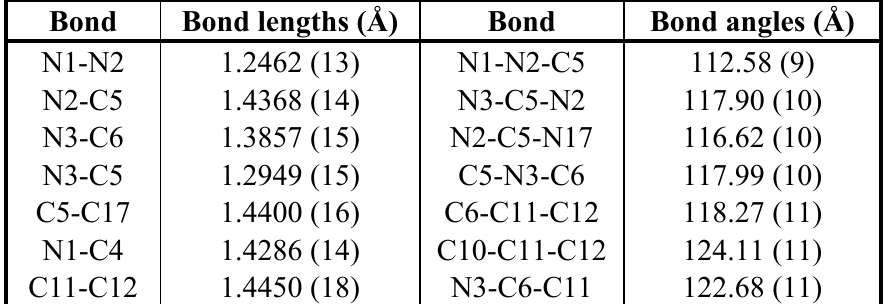
Table 1. Selected bond lengths and bond angles for compound 9a